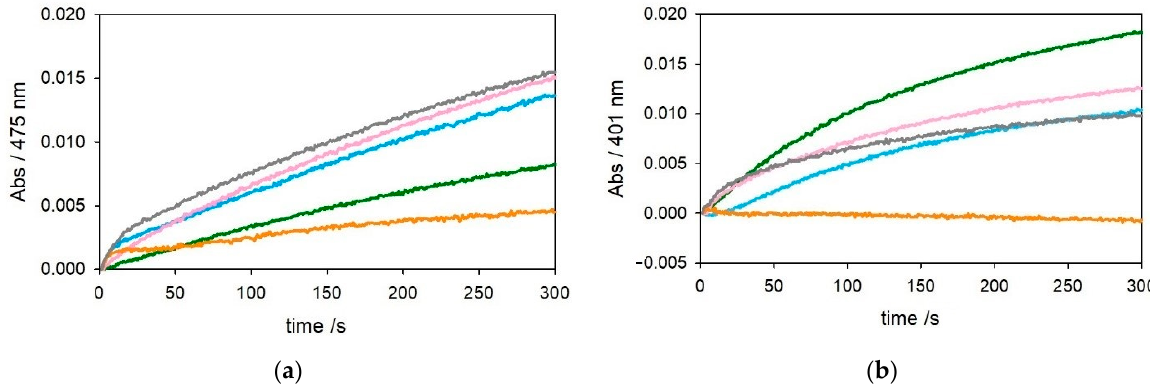
Figure 4. Kinetic profiles of DA (0.3 mM, panel ( a )) and MC (0.3 mM, panel ( b )) oxidation with time in 50 mM HEPES buffer at pH 7.4 and 20 °C in the presence of Cu II alone (25 µM, green trace) and with 1 equiv. A β 1–28 (25 µM, pink), 2 equiv. A β 1–28 (50 µM, grey), 1 equiv. A β 4–28 (25 µM, light blue), and 2 equiv. A β 4–28 (50 µM, orange).